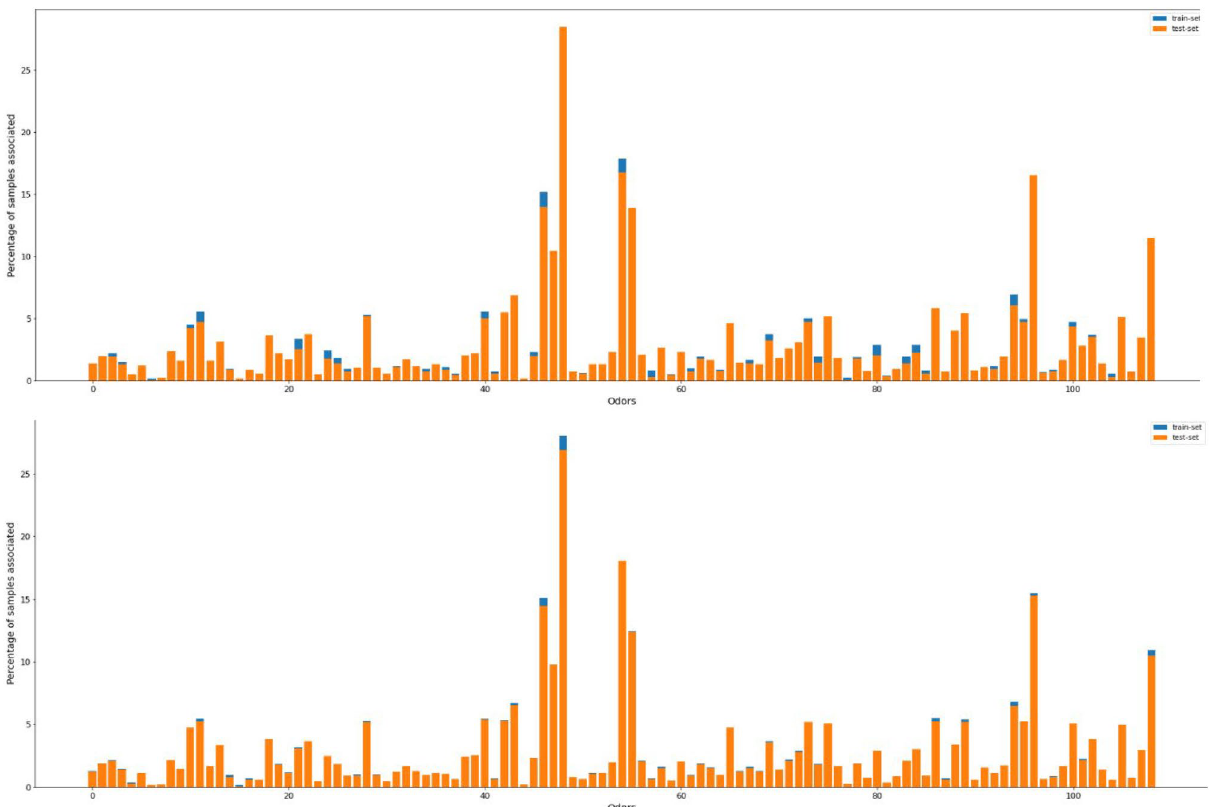
Figure 6. Random split versus a stratified split respectively on the data. The difference in the height of blue and orange bars represents the relative difference in the occurrence of a particular label in the test and training set. It is clearly visible that stratified sampling produces a much more representative training and test